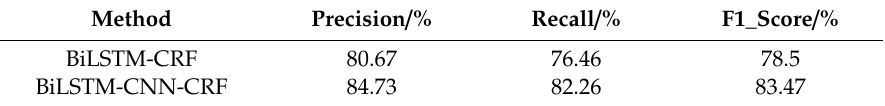
Table 7. Comparison of experimental results after adding CNN model.